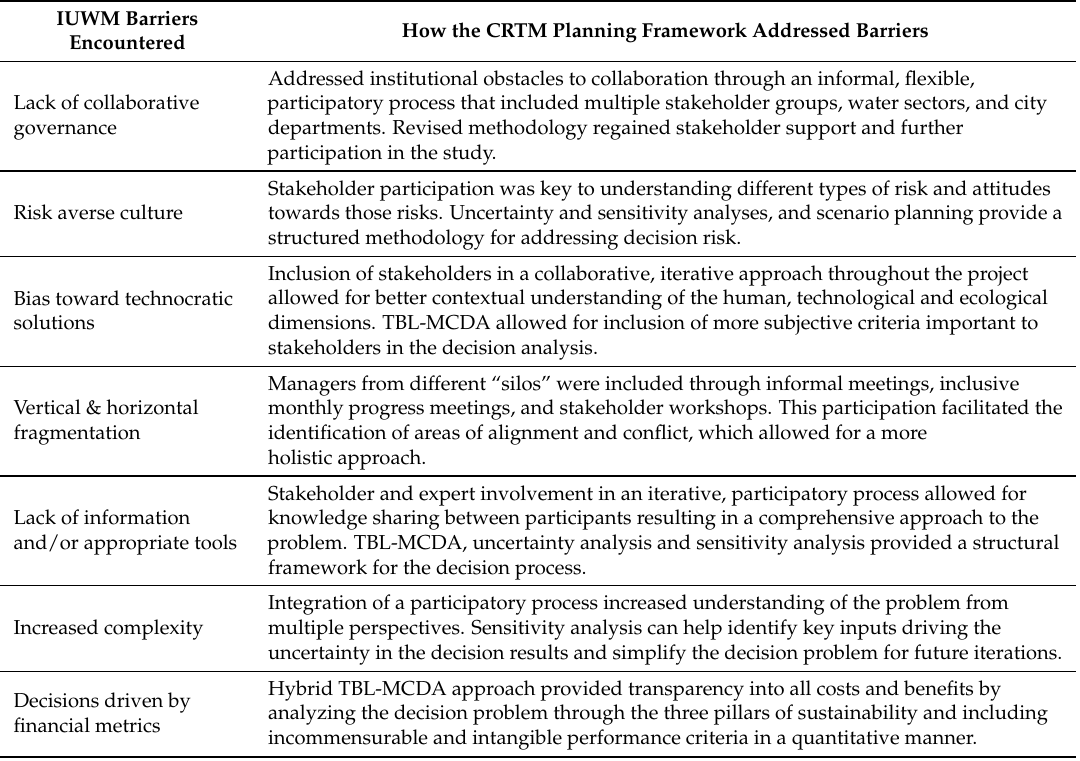
Table 1. How the CRTM planning framework addressed barriers to IUWM decision